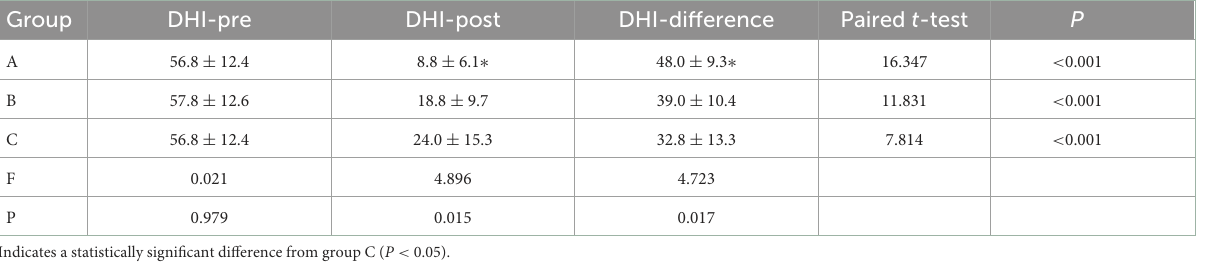
TABLE 7 Results of two-way ANOVA of VAS-QLV. Source